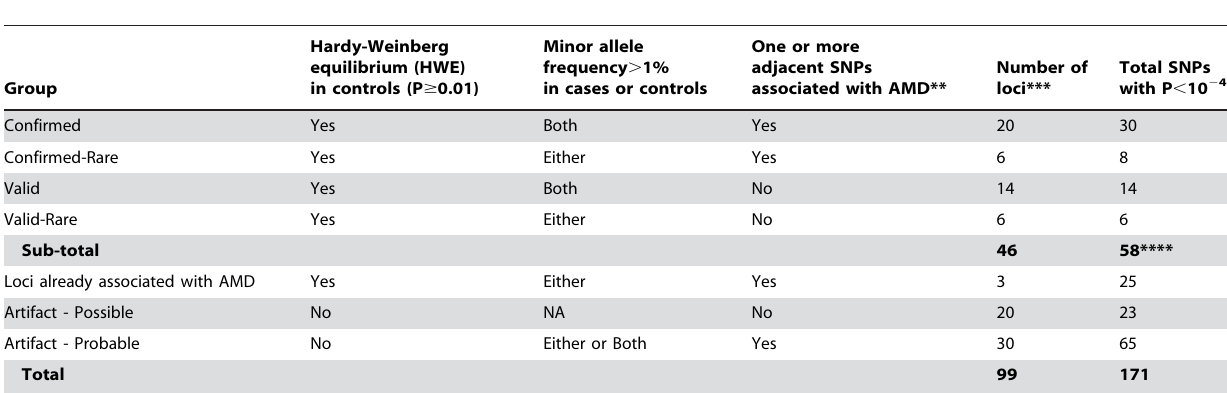
Table 1. Number of loci with at least one SNP significantly associated with AMD in the 100,000 SNP genome-wide scan of the AREDS